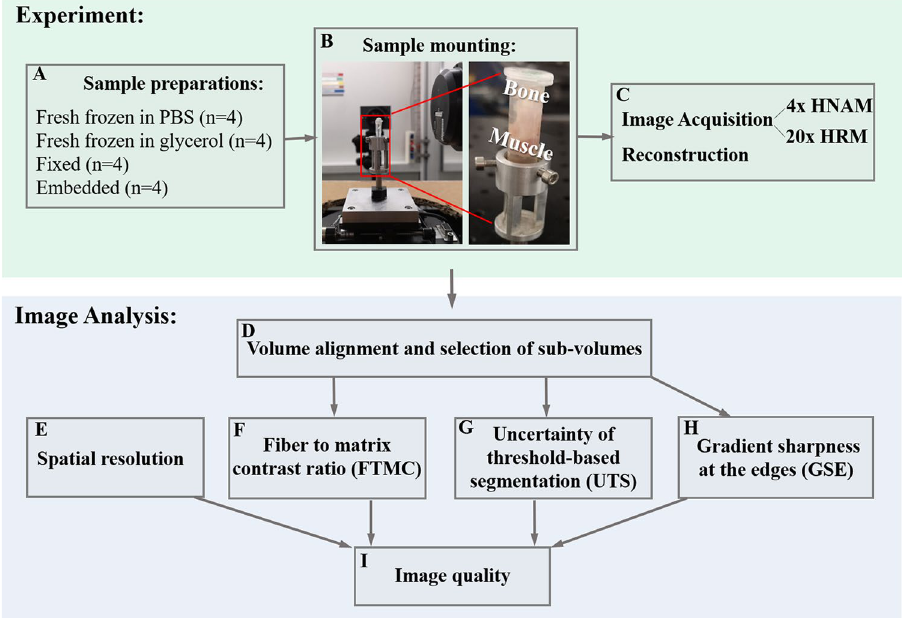
Figure 1. Schematic of the overall study. ( A ) 16 tendons were divided into four types of sample preparations. ( B ) The samples were mounted in Eppendorf tubes with the bone on the upper side and the muscle in the tube tip. The tubes were carefully fixed into the sample holder. ( C ) Imaging of the samples were performed using two different microscope setups. ( D ) The volumes were aligned, and sub-volumes were selected for analysis. ( E – H ) Image analysis determined four parameters. The four parameters were used to determine overall image quality ( I